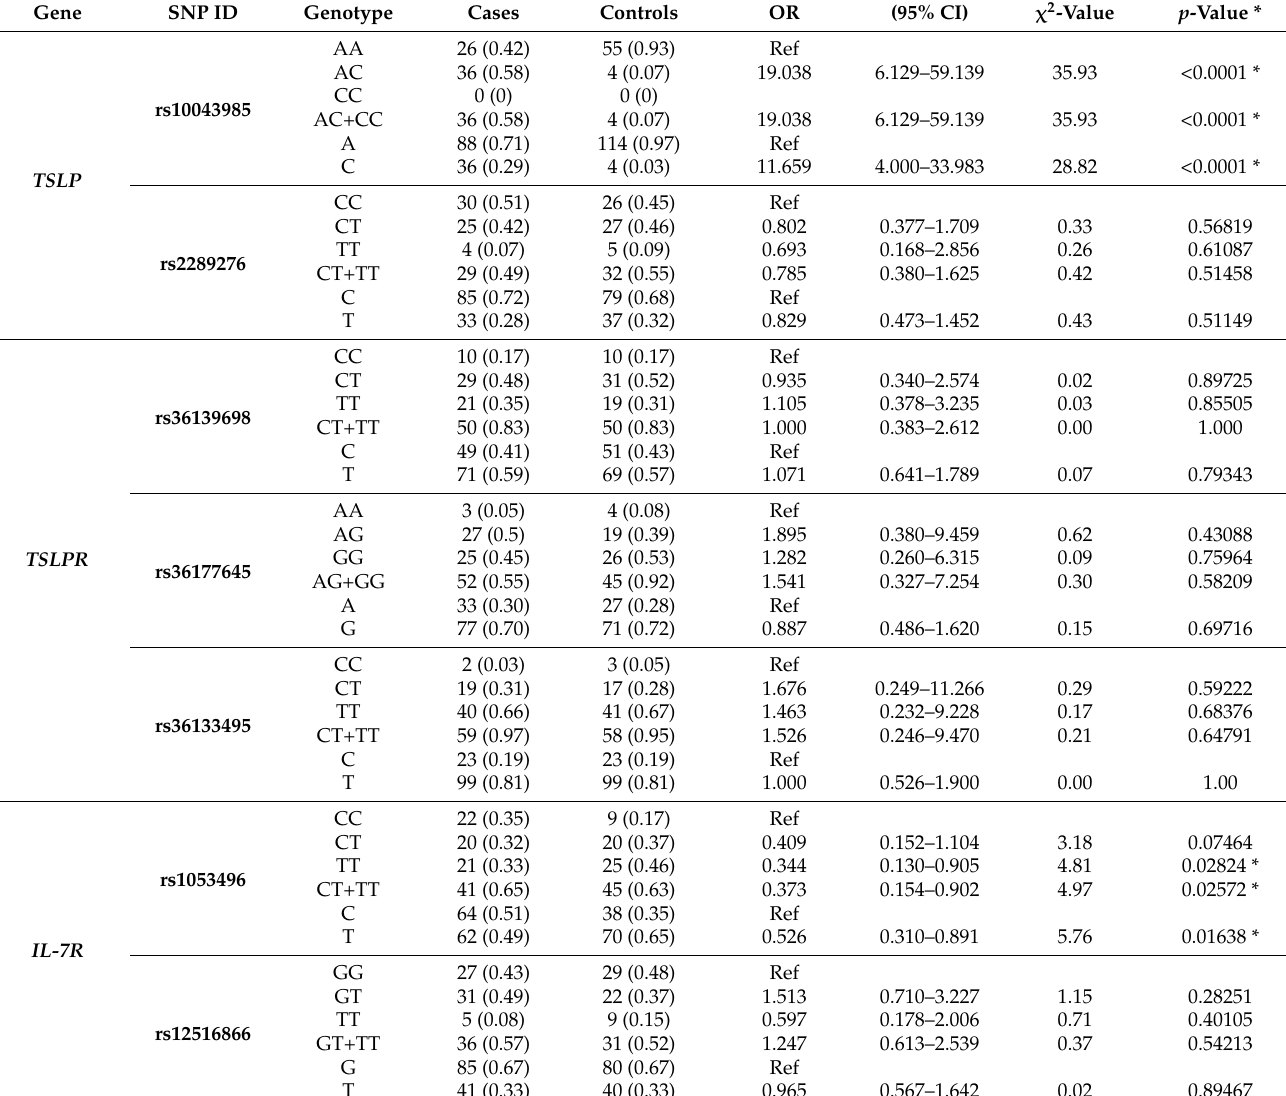
Table 7. Genotype frequencies of TSLP, TSLPR, and IL-7R gene polymorphisms in CRC and controls in male